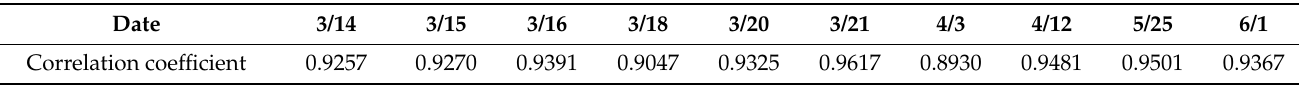
Correlation coefficient 0.9257